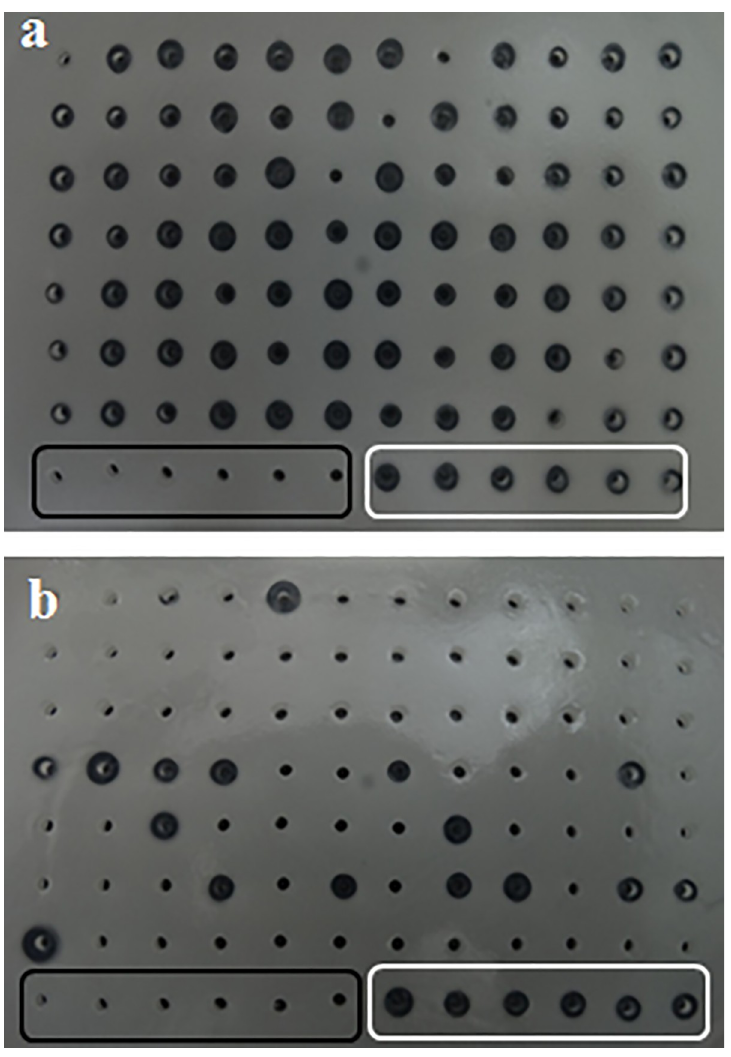
Fig 3. Halo formation by mutants of GTL on agar-tributyrin plate. Wells within black rectangle are negative controls (without any lipase) and wells within white rectangle are positive controls (contain GTL). (a) Most of the mutants at position 244 are active, (b) while mutants at position 359 are mostly